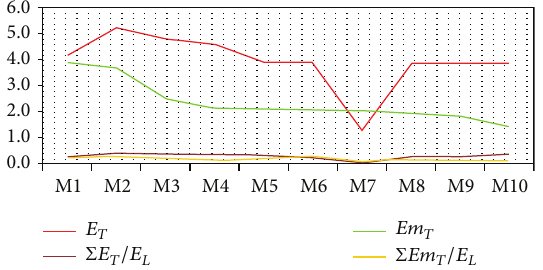
Figure 14: Diagrams of total electric field strength and the sum of quotient.